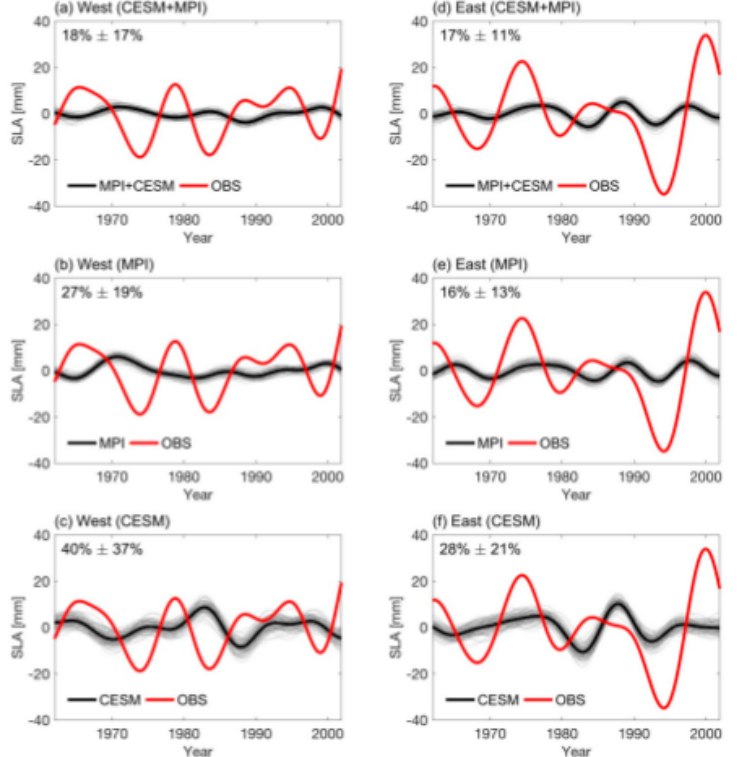
Figure 5. The time series of the 8 year lowpass filtered decadal SLA (mm) averaged over the Seychelles Island area in the west (Reg. 1 of Figure 4) and near the ITF area in the east (Reg. 2 of Figure 4) from 1962–2001. ( a ) The time series of the 100 members that represent external forcing, with each member being the ensemble average of the randomly chosen N members from the total MPI and CESM (140 members) averaged in Reg. 1 (thin curves), the effect of the external forcing represented by the 100-member ensemble mean (thick black curve), and the observation represented by the average of ORAS4 and SODA (red curve); the 18 ± 17% are the STD ratios between the external-forced and observed SLA and its uncertainty (1.65STD of spread, shown by the gray shading); ( b , c ) are the same as (a) but for the MPI 100 members and the CESM 40 members, respectively; ( d – f ) are the same as ( a – c ) except that they are averaged in Reg. 2. See the last paragraph of Section 3.1 for a detailed discussion on the Monte Carlo method to obtain the 100 members of external forcing and the choice of N